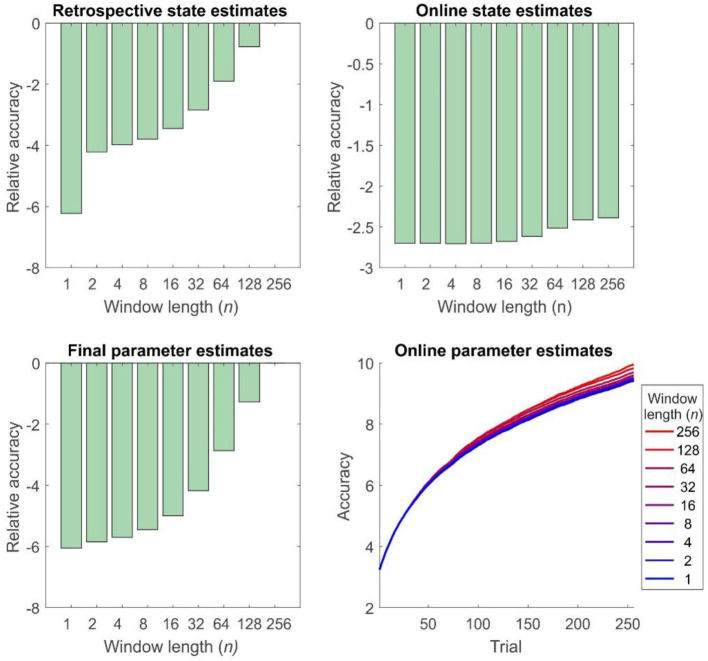
Accuracy of inference and learning for random HMMs (see “Simulations” for more details). In general these mirror the results for the reversal task (Figure 5), but the quantitative differences are smaller, perhaps reflecting the greater number of states and parameters to be estimated (Accuracy is quantified as the log likelihood assigned to the true sequence of states or the true parameter value by the agent, averaged across simulations). Top left panel: accuracy of state estimation increases with window length, becoming identical for online and offline agents with the same effective window length (256 trials). Top right panel: accuracy of online (filtered) state estimates relative to the filtered state estimates of an offline agent. Accuracy increases with window length, but never becomes equivalent to that of an offline agent. Bottom left panel: accuracy of final parameter estimates relative to the performance of an offline agent. As the window length employed increases, so does accuracy, becoming equivalent for online, and offline agents with the same effective window length. Bottom right panel: average accuracy of parameter estimates across trials. Accuracy of parameter estimation increases with window length, and these differences progressively appear as the session goes on.